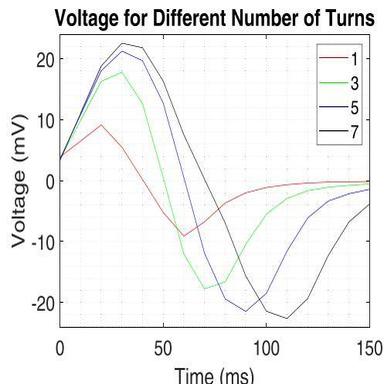
Simulated voltage vs time for 500 mm/s and different numbers of turns.